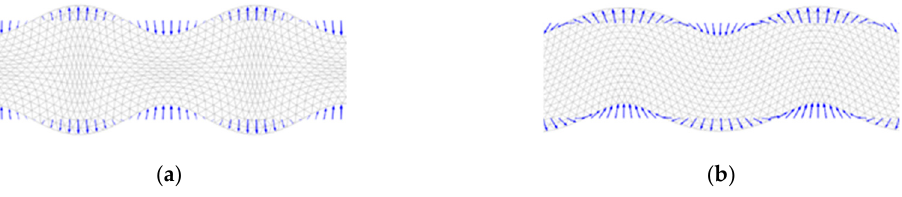
Figure 3. The displacement form of symmetric and antisymmetric Lamb waves: ( a ) symmetric mode, and ( b ) antisymmetric mode.